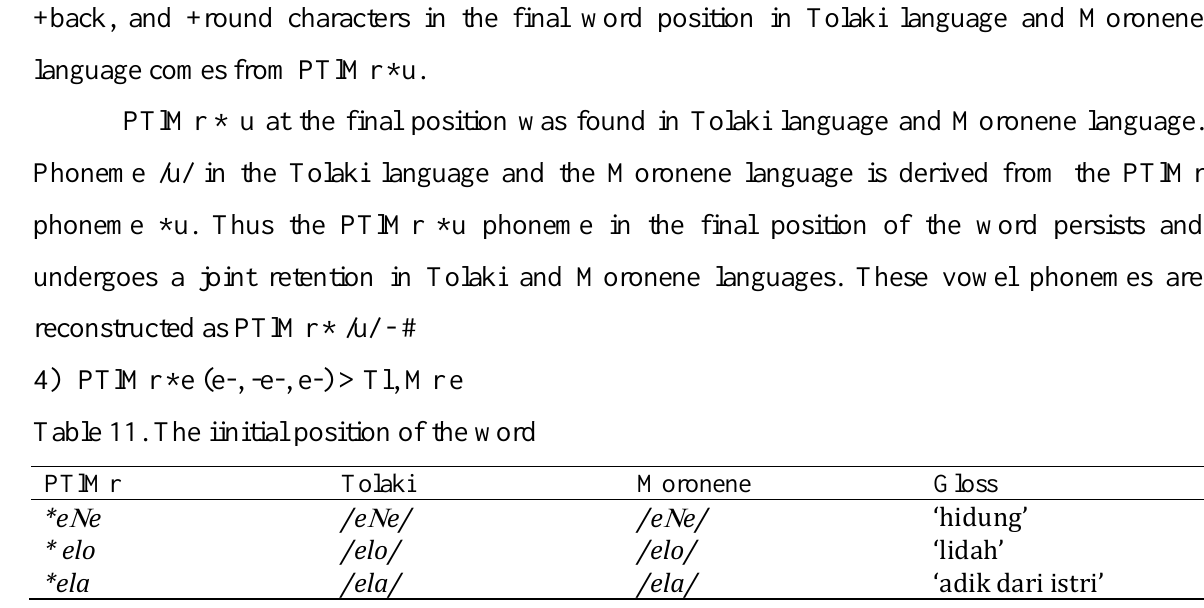
Table 12. The Middle Position Word PTlMr Tolaki Moronene